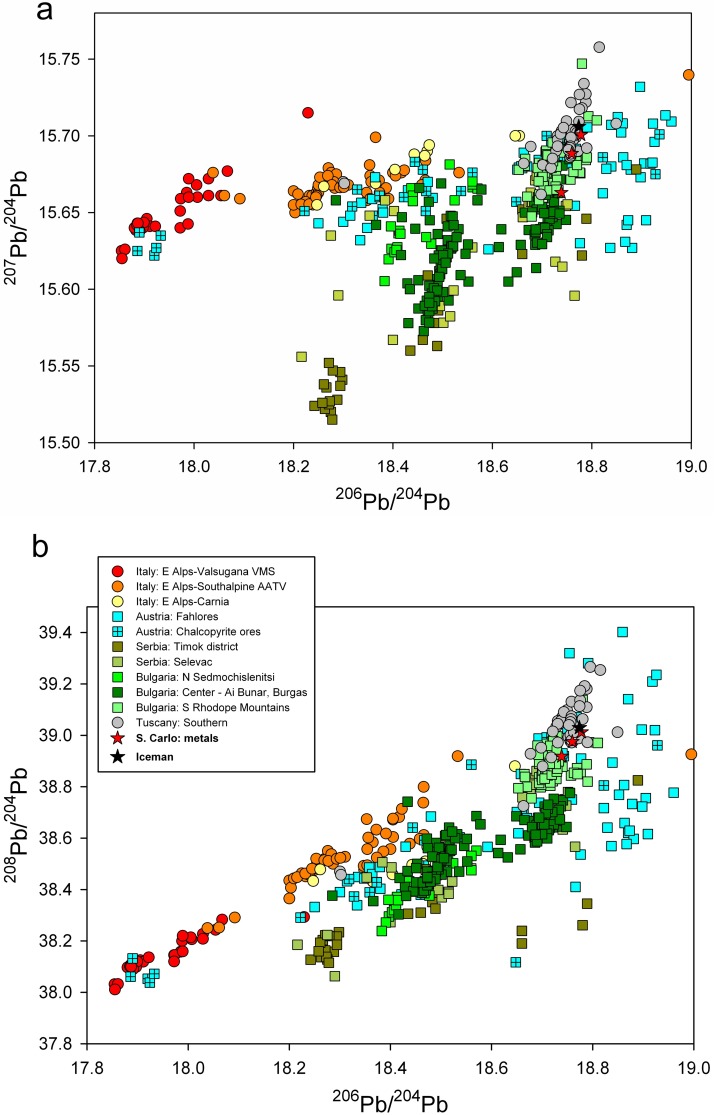
2D projections of the measured lead isotope ratios, compared with the available data from the literature [22, 28–32 and literature cited therein].The two most widely used bivariate plots are shown: (a) 206Pb/204Pb vs 207Pb/204Pb plot; (b) 206Pb/204Pb vs 208Pb/204Pb plot.